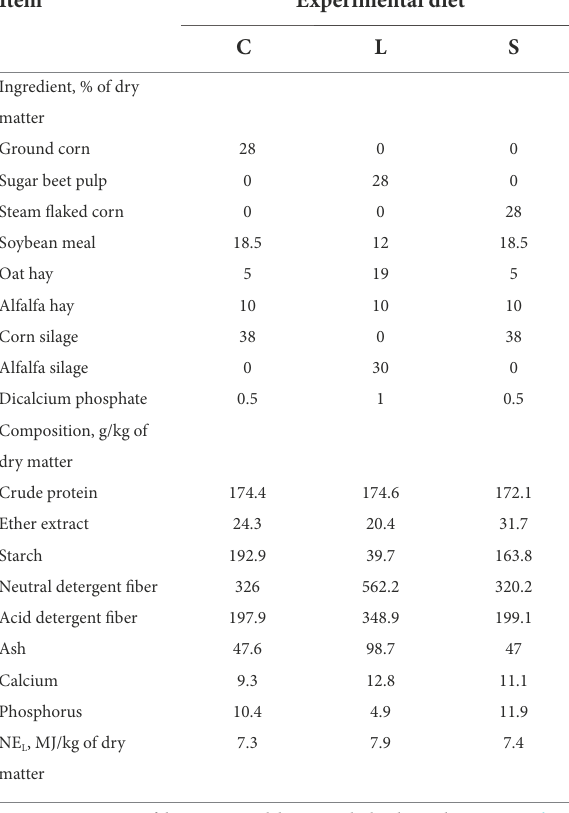
TABLE 1 Ingredient and nutritional composition of two glucogenic (C, S) and a lipogenic (L) diet. Item Experimental